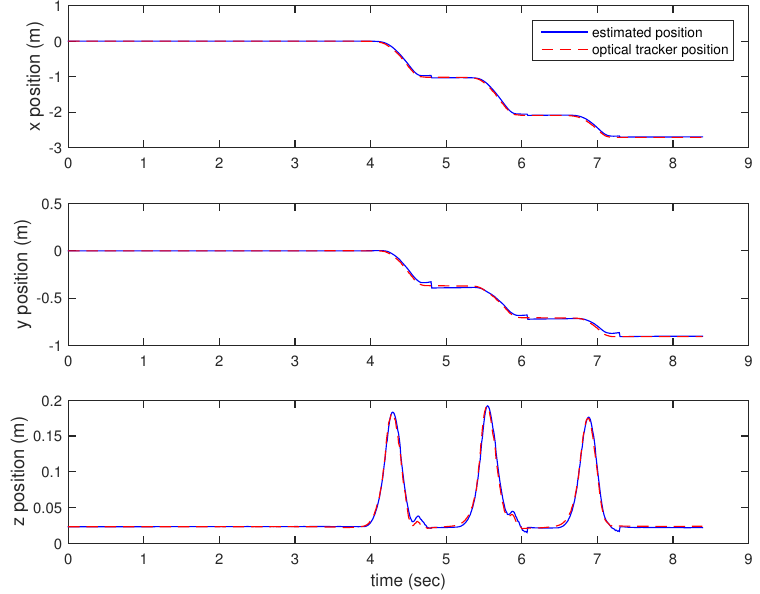
Figure 3. Walking position estimation: proposed method.